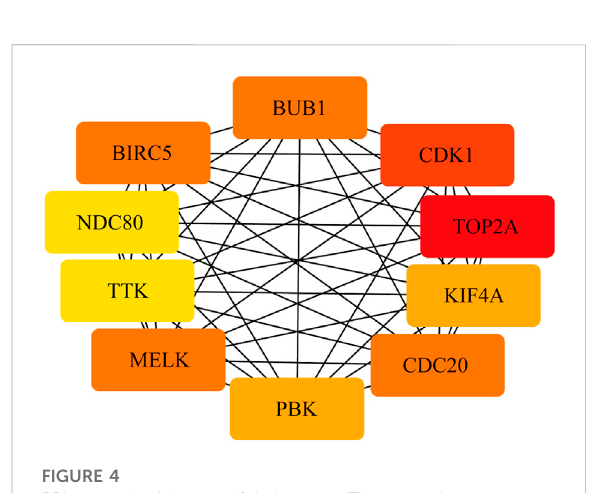
FIGURE 4 PPI network of the top 10 hub genes. There are close interrelationships among the 10 hub